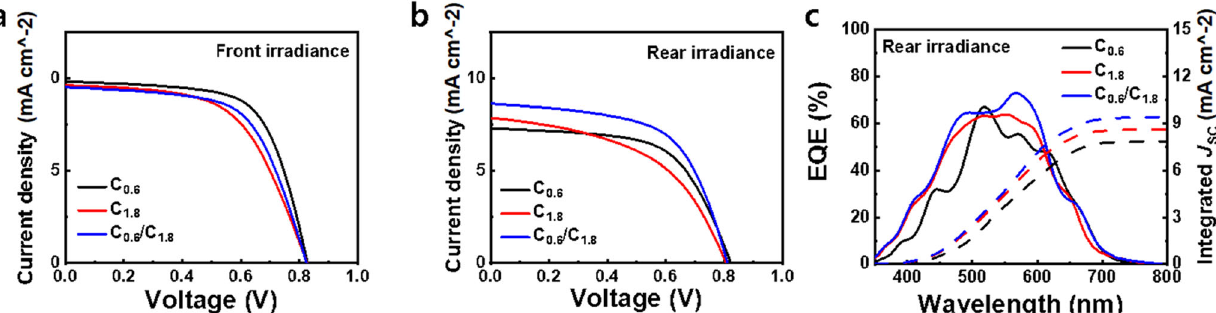
Fig. 6 Flexible TSCs characteristics with rear-window layers. Effects of three different structures (C 0.6 , C 1.8 , and C 0.6 /C 1.8 ) of n- μ c-SiO x :H on J – V curves of TSCs deposited on T-CPI with etching time of 2 min for cases of a front-side and b rear-side irradiance. c EQE spectra and integrated J SC values of above cells for case of rear-side